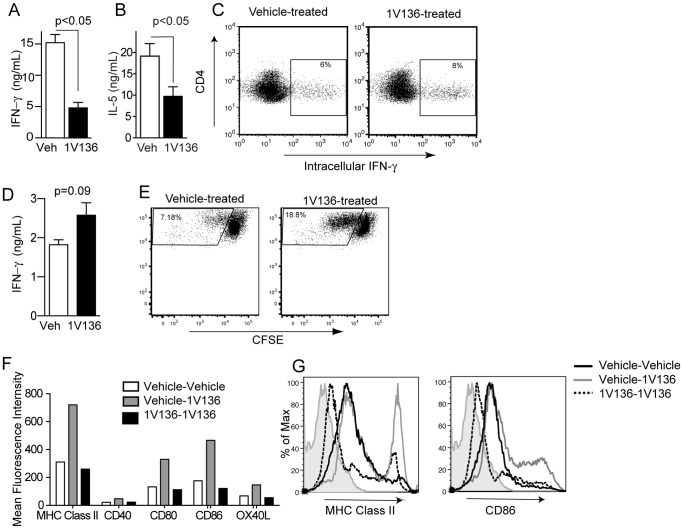
TLR7 ligand treatment reduced antigen specific T cell responses and dendritic cell activation.C57BL/6 mice (n = 5/group) were intradermally immunized with OVA (50 µg) mixed with (A) ISS-ODN (50 µg) or (B) alum (0.5 mg) on days 0 and 7. Immunized mice were treated daily with 1V136 (150 nmol/mouse) (black bar) or vehicle (white bar) s.c. from day 7 onward. On day 21 mice were sacrificed and splenocytes were harvested. Splenocytes were cultured with OVA (100 µg/ml) ex vivo for 5 days, and IFN-γ (A) or IL-5 (B) in the culture supernatant was measured by ELISA. p<0.05 by Student t test compared to vehicle treated. (C) On the day of harvest the splenocytes were also nonspecifically stimulated with PMA and ionomycin, and CD4+ T cells were analyzed by flow cytometry for intracellular IFN-γ. Data shown are representative of three independent experiments that exhibited similar results. (D) C57BL/6 mice (n = 5/group) were intradermally immunized with OVA (50 µg) mixed with ISS-ODN (50 µg) on days 0 and 7. Immunized mice were treated daily with 1V136 (150 nmol/mouse) (black bar) or vehicle (white bar) s.c. from day 5 onward. On day 21 mice were sacrificed and splenocytes were harvested and enriched for CD4+ cells by magnetic beads. The enriched CD4+ T cells were cultured with OVA (100 µg/ml) and BMDCs for 3 days and IFN-γ in the culture supernatant was measured by ELISA. p<0.05 by Student t test compared to vehicle treated. (E) An aliquot of the enriched CD4+ T cells above were CFSE labeled, and cultured for 3 days with BMDC and OVA. The proliferation was assessed by flow cytometry. (F) BMDCs were treated with 1V136 (1 µM) or vehicle for 18 h, washed and restimulated with 1V136 (1 µM). The expression of MHC class II, CD40, CD80, CD86, or OX40L in the gated CD11c population were evaluated by flow cytometry. The data shown are representative of three independent experiments. (G) Representative histogram plots of MHC class II and CD86 in the CD11c+ gated populations are shown. Light gray areas are isotype controls.